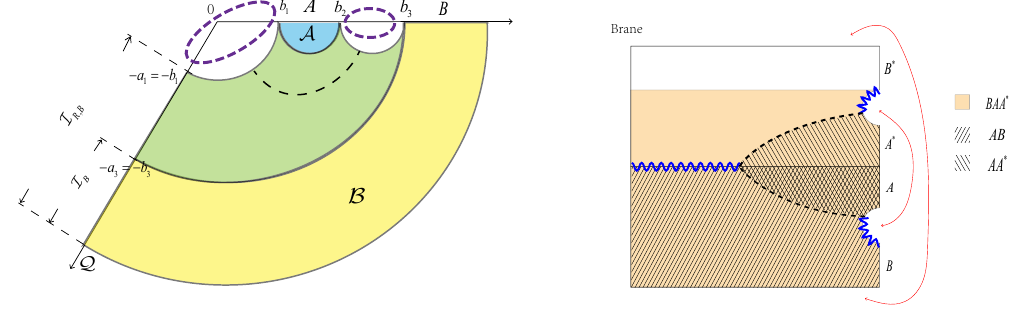
Figure 6 . Phase-D2. Left: the blue and yellow regions denote the entanglement wedges of A and B , respectively. The green region denotes the shared entanglement wedge of AB . The black dashed line denotes the entanglement wedge cross-section between A and B . From the 2d boundary viewpoint, there are islands on the brane. I and I R denote the island for entanglement entropy and reflected entropy, respectively. The purple dashed circles are the boundary gap between A ∪ I R,A and B ∪I R,B , and there are two gaps for phase-D2. Right: the canonical purification of ρ AB and the entanglement wedges for AB, AA ∗ , BAA ∗ . The red double-headed arrows denote the identification between two spacelike surfaces of the entanglement wedges. The small tubular neighborhoods of two blue jagged lines here are completely visible to BAA ∗ , while not to AB or AA ∗ . The entanglement wedges satisfy W( AA ∗ B ) ⊃ W( AB ) ∪ W( AA ∗ ) . This signals the non-vanishing Markov gap for this